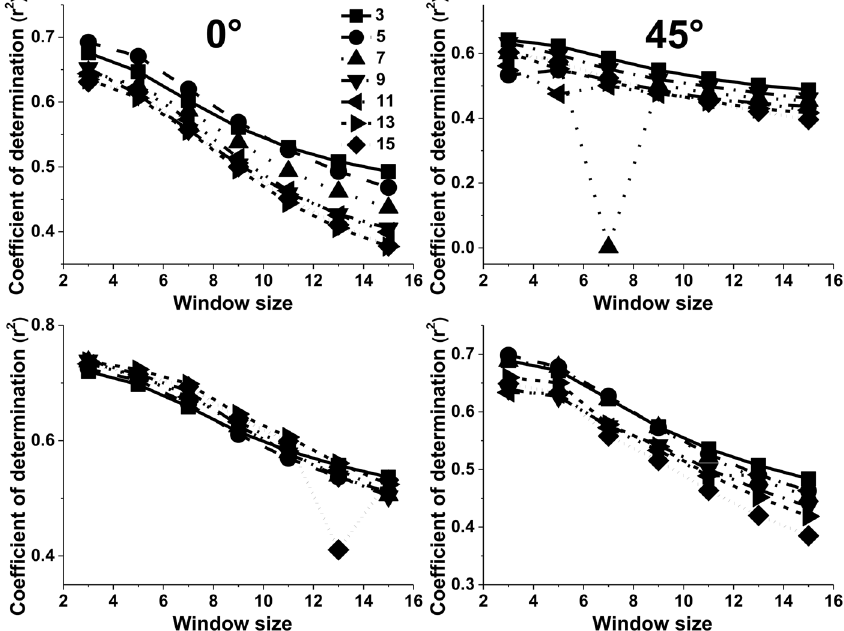
Figure 6. The effect of the window size on the values of adjusted r 2 for ASM.